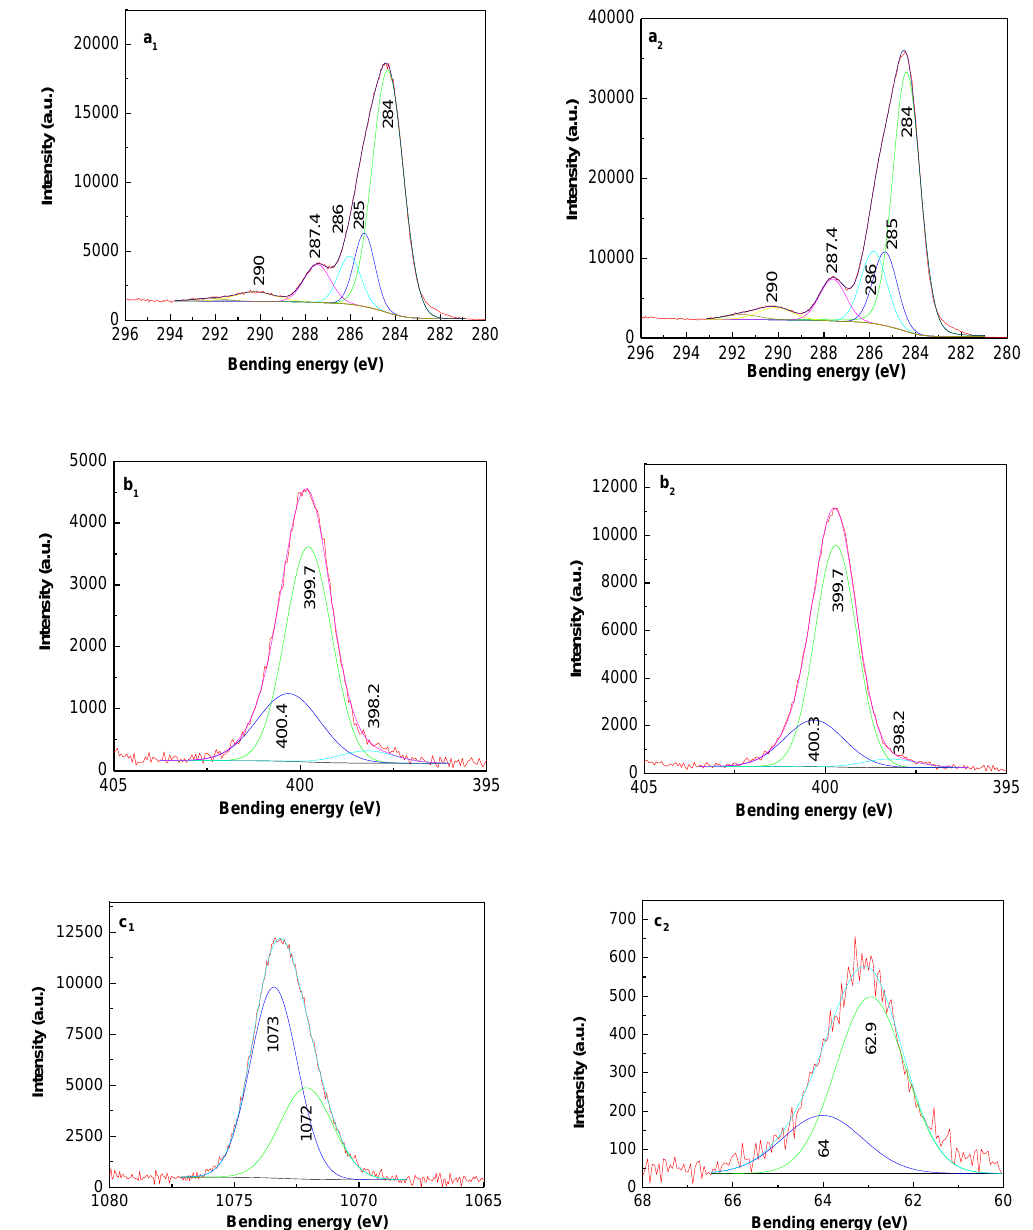
Figure 8. XPS C1s ( a ) and N1s ( b ) spectra of AC ( a 1 , b 1 ) as well as AC interacted with NaOH ( a 2 , b 2 ). ( c 1 , c 2 ) show XPS Na1s and Na2s spectra of AC interacted with